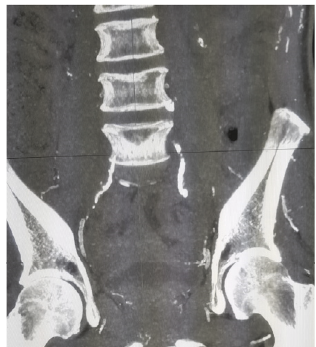
Figure 3: Bilateral obstructive calcification of internal illiac vessels.